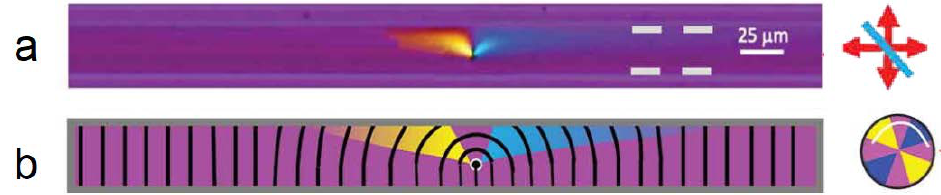
Figure 11. ( a ) shows the appearance of a 25 µ m-wide stripe of a columnar mesophase around a single disclination (extending upwards from the centre line of the stripe), when viewed between crossed polars with a red 1 λ plate inserted. In Figure ( b ), the black lines have been added to indicate the inferred director field. Note the distribution of the yellow and blue areas, indicating the extent of the regions of splay extending from the singularity. The orientation diagram shown on the right shows the alignments corresponding to the blue, magenta, and yellow regions of the image. The white arc indicates the range of orientations within the director field of the sample. Taken from Bramble et al. [21].